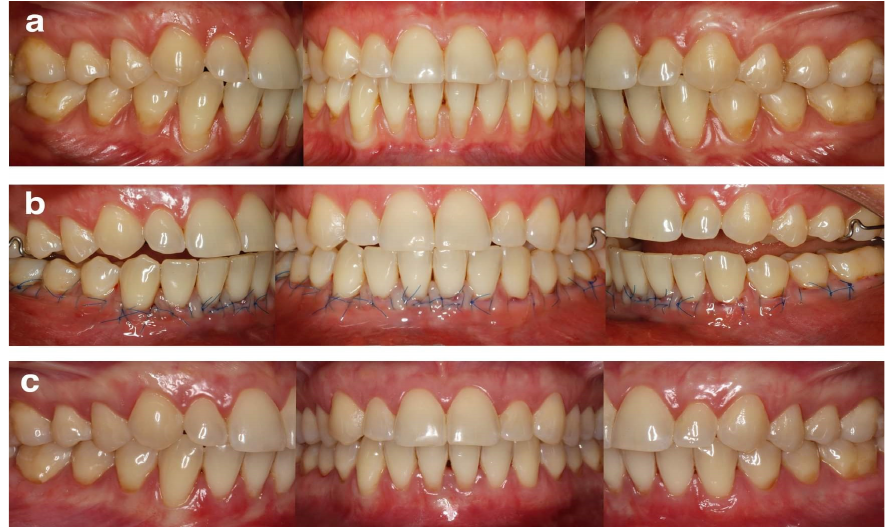
Figure 2. Representative case of symmetrical multiple gingival recessions at mandibular teeth ( a ) pre-operative view of gingival recessions; ( b ) immediate post-operative view; ( c ) 24 months post- operative view.